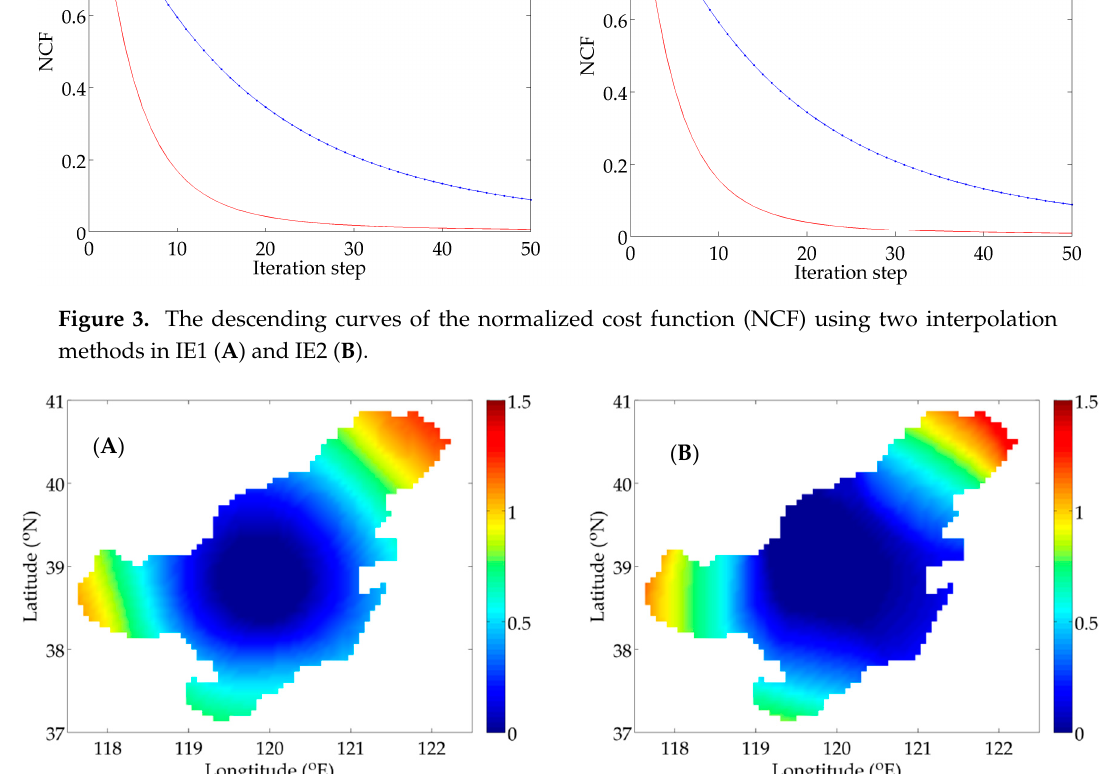
Figure 3. The descending curves of the normalized cost function (NCF) using two interpolation methods in IE1 ( A ) and IE2 ( B ). Table 2. The results of the quantitative metrics using two interpolation methods in the idealized twin experiment 1 (IE1).